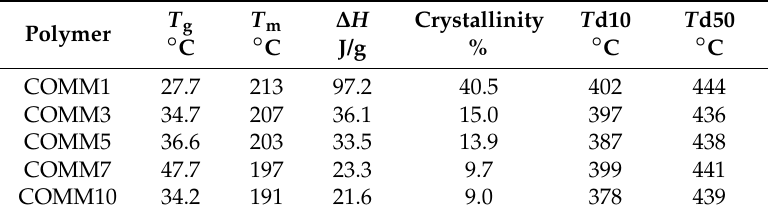
Figure 8. TGA of PA6 containing dimer oleic acid and 4,4'-Methylenebis(2-methylcyclohexylamine).